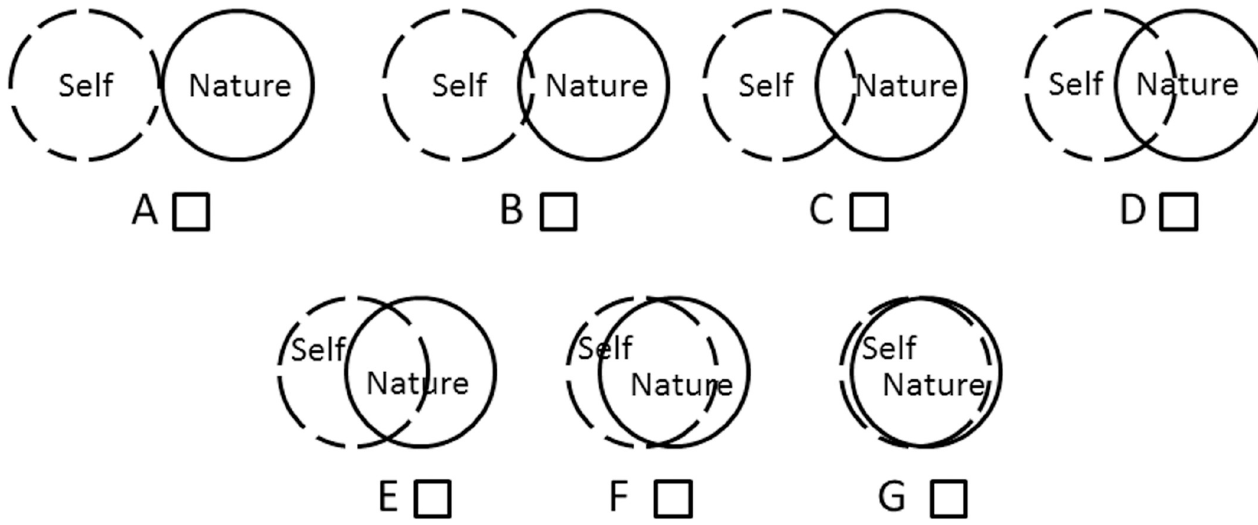
Fig 5. INS adapted with two overlapping circles labelled ‘nature’ and ‘self’ [19].